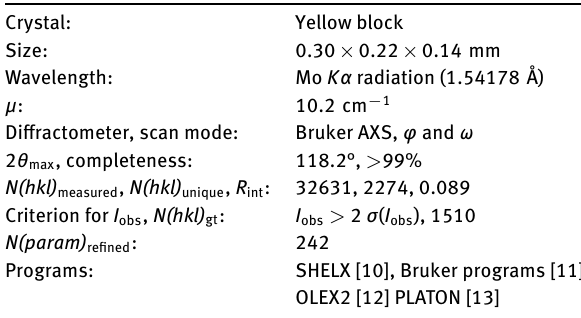
Table 1: Data collection and handling.